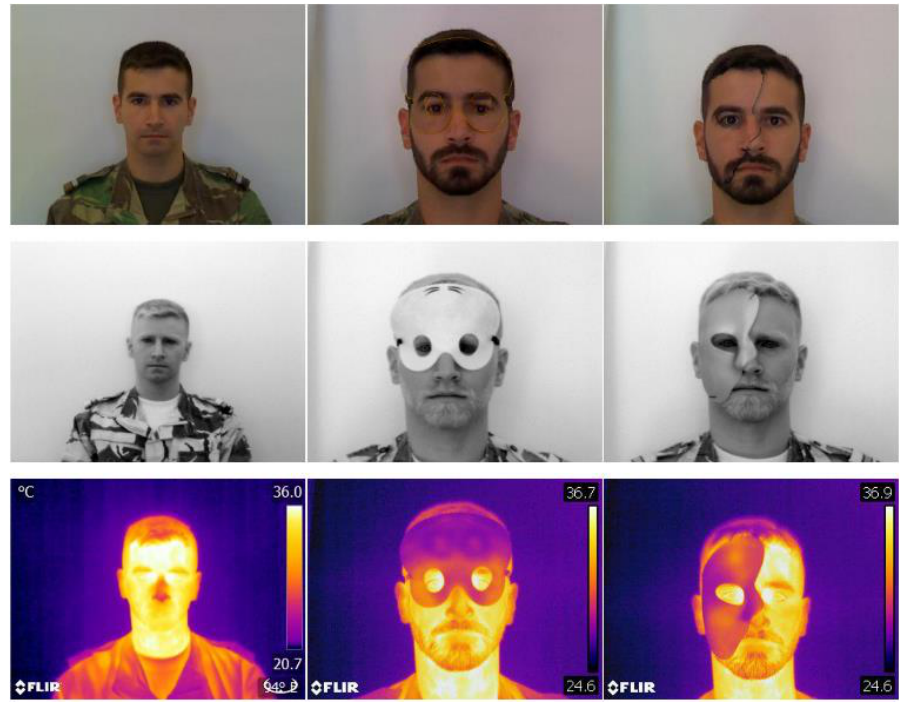
Figure 4. Example of images from our AM multispectral database.